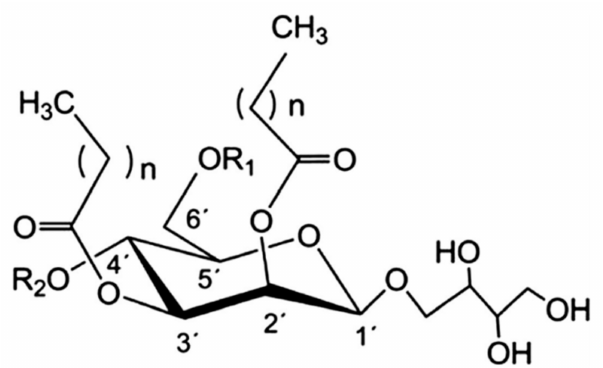
Figure 3. Chemical structure of mannosylerythritol lipids (Adapted from [80]).